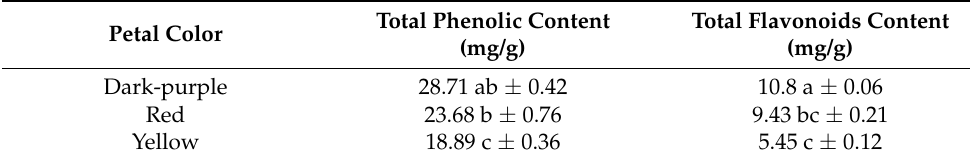
Table 2. Comparison of total phenolic compounds and flavonoids in the essential oils for different colors of P. delavayi